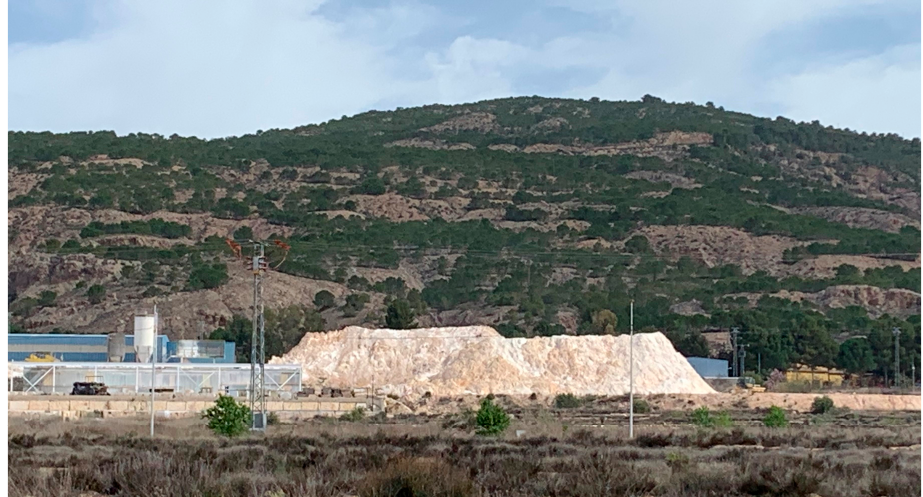
Figure 1. View of a natural stone company’s temporary landfill for limestone powder waste in southeastern Spain.